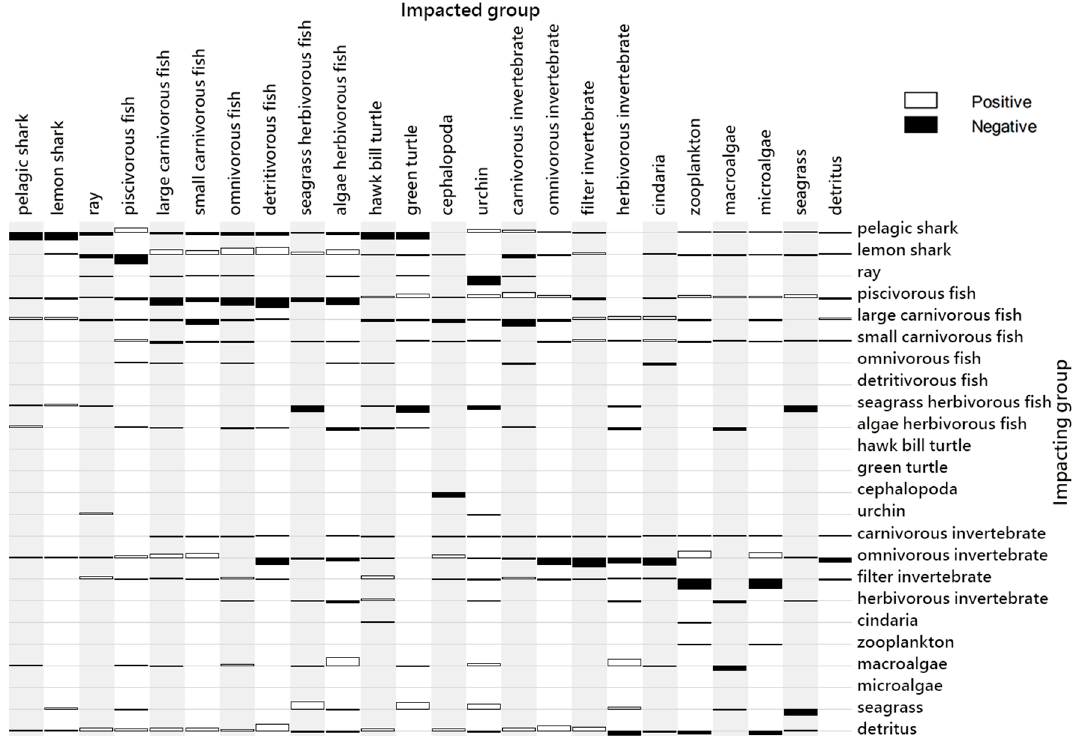
Figure 3. Lindeman spines of organic matter (g wet weight m − 2 yr − 1 ) and trophic efficiencies (TE, %) in different trophic levels from Level I including primary producer (P) and detritus (D) to consumers at Level II–VI in the Dongsha seagrass bed model. P: primary producers; D: detritus; TL: trophic level; TST: Total system throughput; and TE: transfer efficiency.